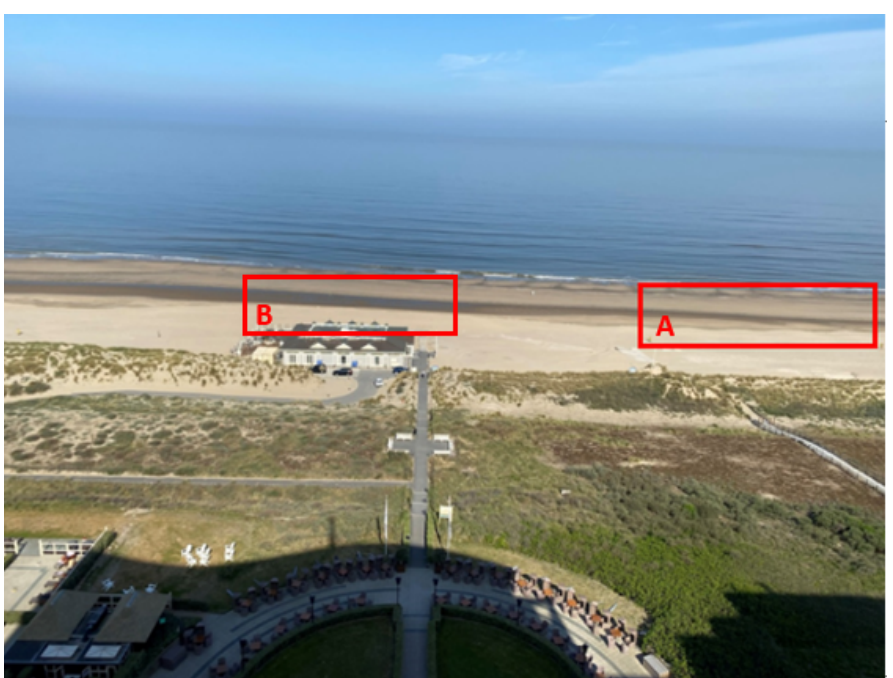
Figure 3. Partial view of the TLS on the beach of Noordwijk and locations of the